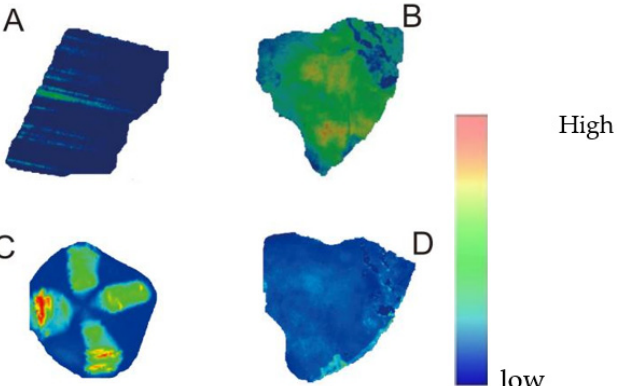
Figure 6. PL mapping images of samples. The baseline-corrected peak area intensity for each laser excitation wavelength. ( A ) Sample GZ-25, the peak area distribution of the 637 nm peak (532 nm excitation). ( B ) Sample GZ-42, the peak area distribution of the 575 nm peak (455 nm excitation). ( C ) Sample J-2, The peak area distribution of the 637 nm peak (532 nm excitation). ( D ) Sample GZ-42, The peak area distribution of the 496 nm peak (455 nm excitation).